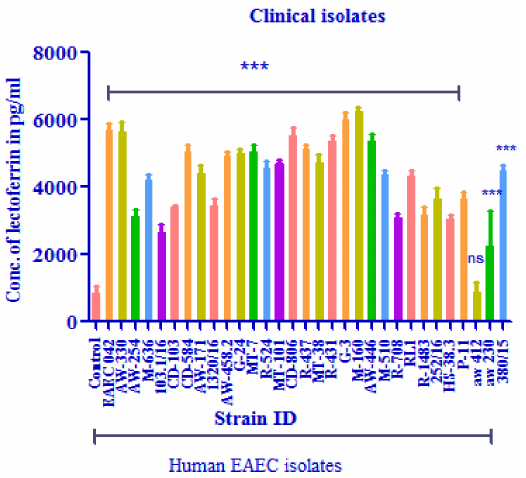
Figure 2. The concentration of lactoferrin (pg/mL) in BALB/c mice infected with the EAEC strain of human origin. *** p , 0.001; comparison by one-way ANOVA with Dunnett’s multiple comparison tests. NS =